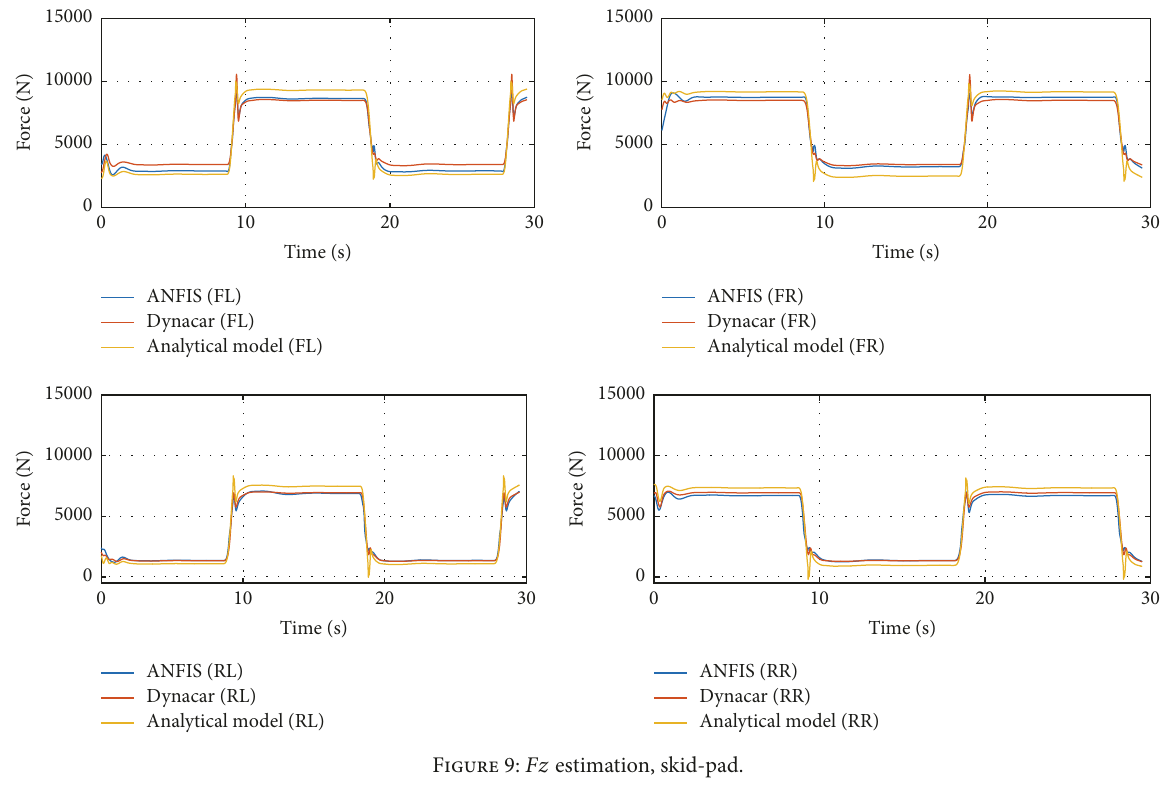
Figure 9: 𝐹𝑧 estimation, skid-pad.